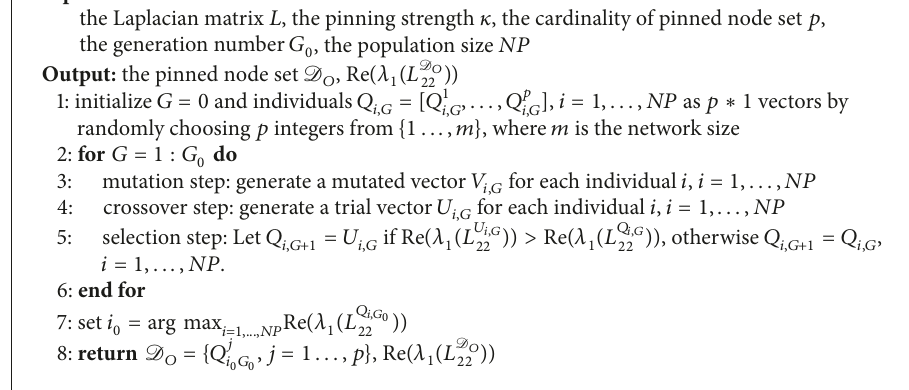
Algorithm 2: Searching for the pinned node set D 𝑂 that maximizes Re (𝜆 1 (𝐿 D 22 ))